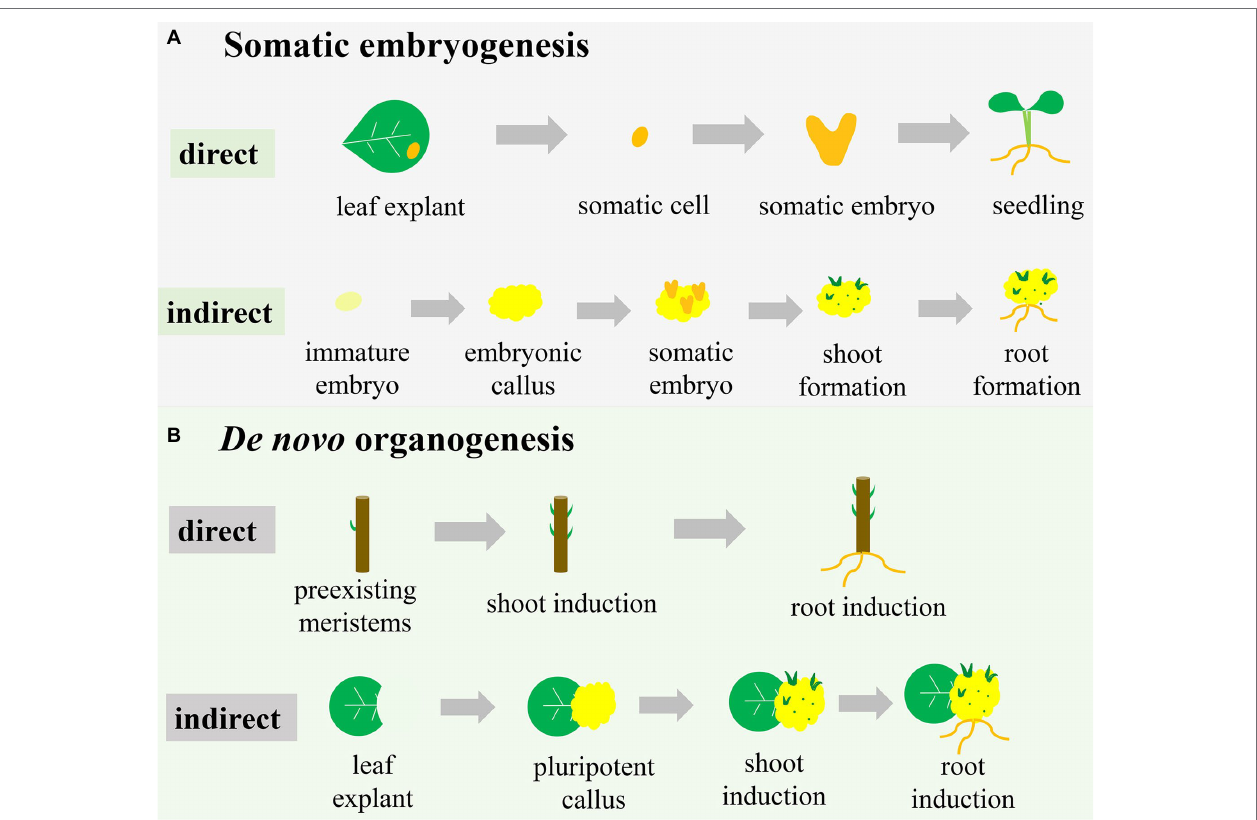
FIGURE 1 | Different pathways of plant regeneration. (A) Somatic embryogenesis. In the direct pathway, the somatic cell originated from explants (e.g., a leaf) is induced to form the somatic embryo, which subsequently drives the development of the whole plant. In the indirect pathway, the explant (e.g., an immature embryo) is induced to initiate the embryonic callus, on which somatic embryos are formed to subsequently develop shoots and roots. (B) De novo organogenesis. In the direct pathway, shoots and roots are induced directly on the stem with pre-existing meristems. In the indirect pathway, pluripotent callus is produced around the wound in a leaf explant, with formation of shoots and roots subsequently